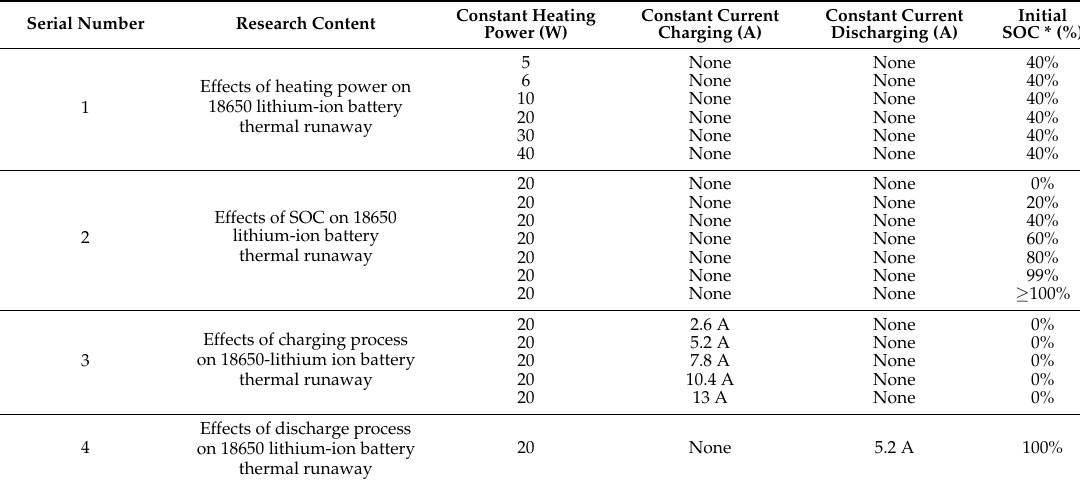
Table 1. Experimental